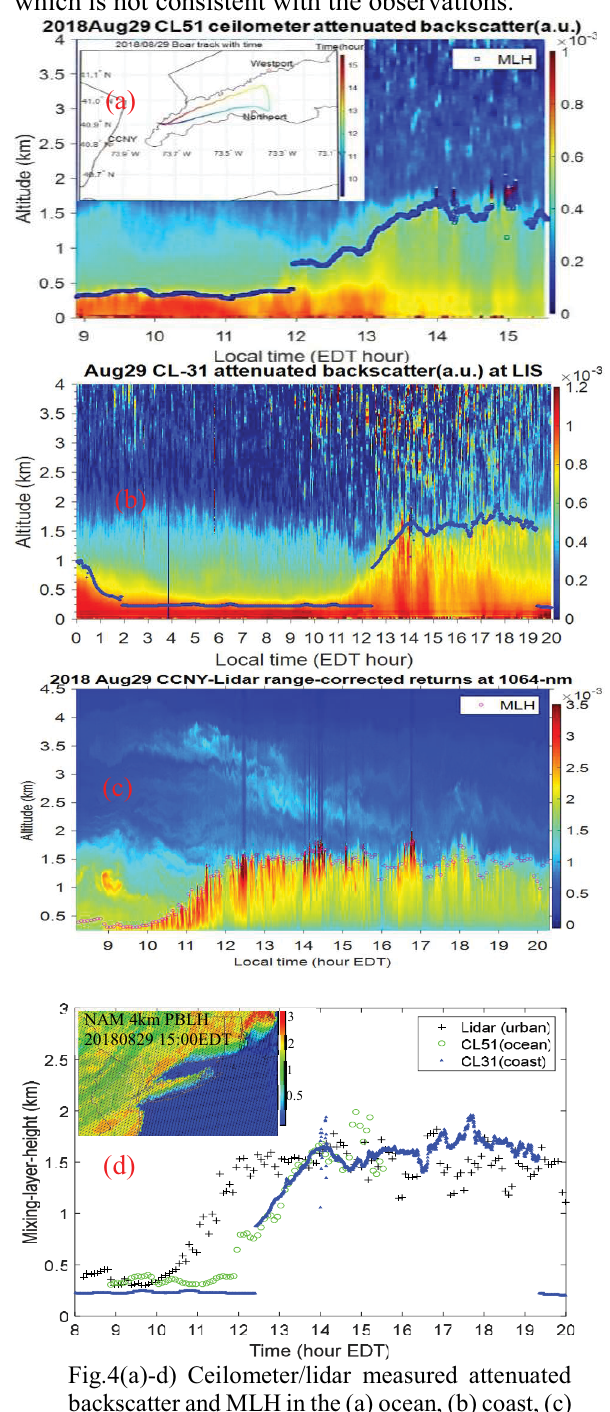
Fig.4(a)-d) Ceilometer/lidar measured attenuated backscatter and MLH in the (a) ocean, (b) coast, (c) urban and (d) their comparison and model MLH in NYC area on Aug. 29,